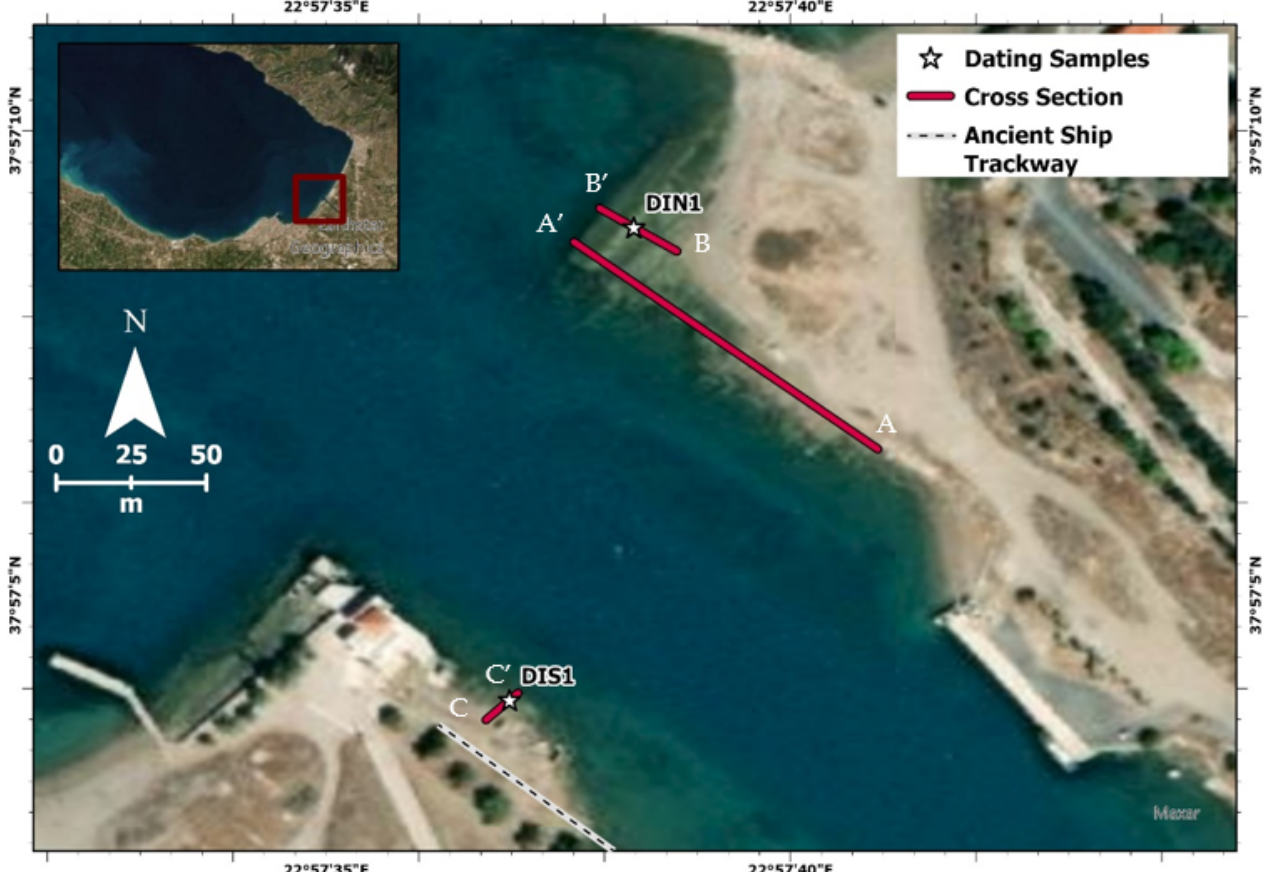
Figure 2. The study area of Diolkos, western part of Corinth canal. In this figure, three cross sections (AA’, BB’, CC’) are illustrated together with the location of OSL samples (DiN1, DiS1). The ancient ship trackway or slipway can be found with the dashed grey/black line.